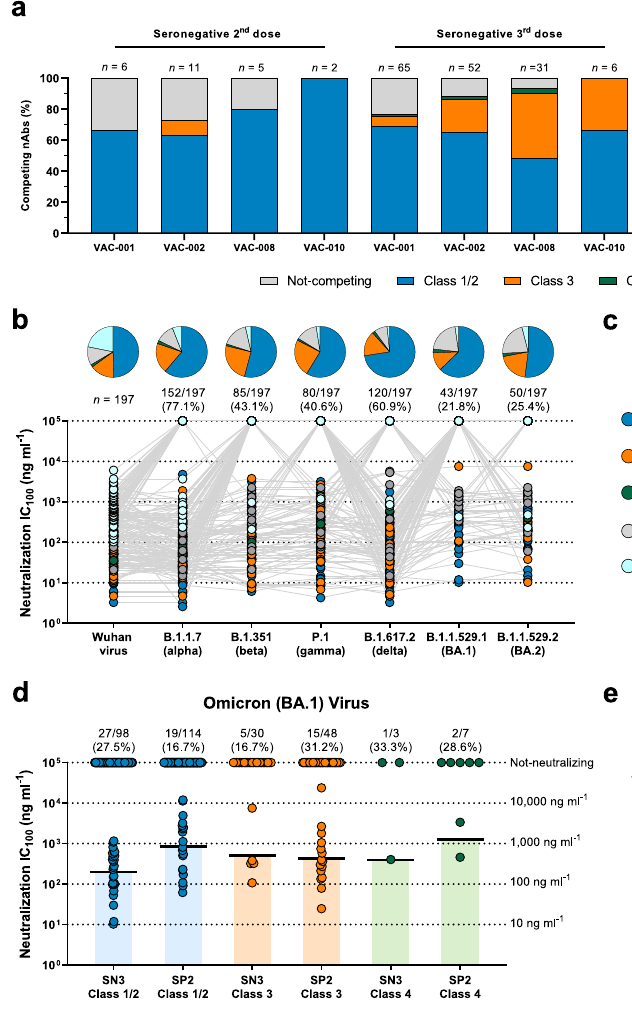
Fig. 2 | Distribution of SN3 nAbs against SARS-CoV-2 VoCs. a The bar graph showstheepitoperegionsrecognizedbyRBD-bindingnAbs.Class1/2,Class3,Class 4, and not-competing nAbs are shown in light blue, orange, green, and light gray, respectively.Thenumber( n )ofantibodiestestedpereachdonorisdenotedonthe graph. The right panel highlights the epitoperecognizedby Class 1/2 (J08),Class 3 (S309)andClass4(CR3022)antibodiesusedinourcompetitionassay. b Piecharts showthedistributionofcross-protectivenAbsbasedontheirabilitytobindClass1/ 2,Class3,andClass4regionsontheRBD,aswellasnot-competingnAbs(gray)and NTD-targeting, nAbs (cyan). Dot charts show the neutralization potency, reported